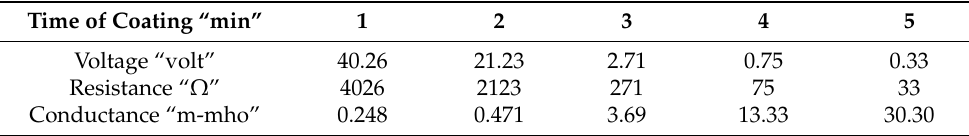
Figure 2. ( a ) Side view of setup to measure the transmitted Light intensity, ( b ) Top view with light source turned on, and ( c ) Schematic of Four probe system. Table 3. Electrical properties of thin films of category